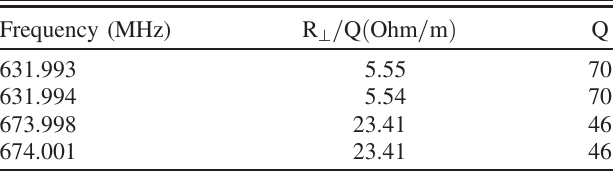
TABLE II. Transverse HOM parameters of SSRF CESR type SC cavity (with ferrite absorbers).